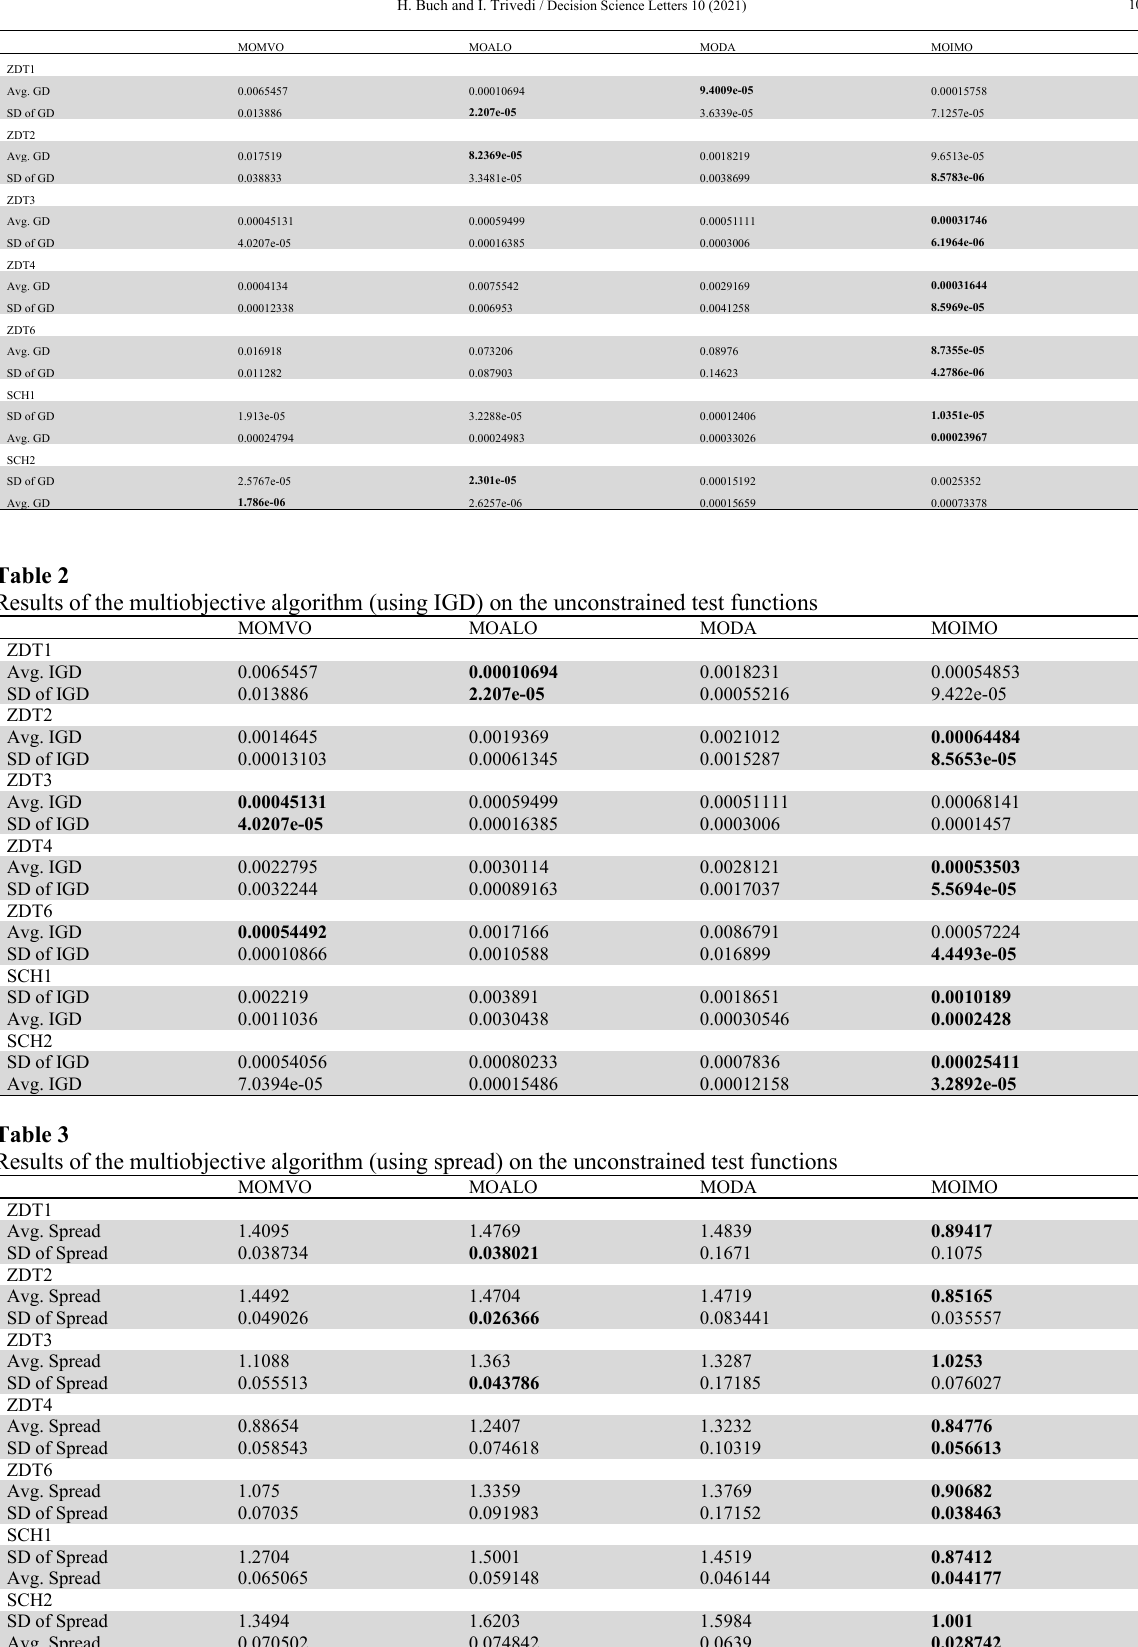
Results of the multiobjective algorithm (using spacing) on the unconstrained test